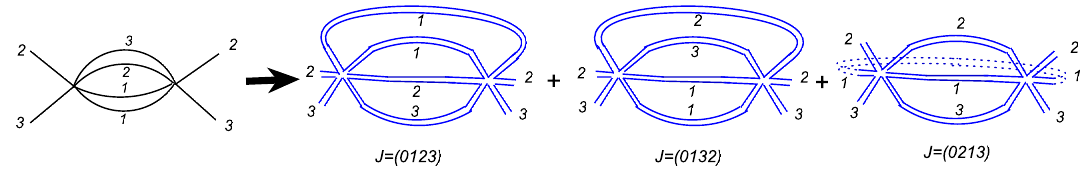
Figure 12 . An example illustrating the existence of a handle for one of the three J ’s in the case when two 6-valent vertices are connected by four lines. The 3 diagrams to the right of the arrow show the three blow-ups of this graph for the three di(cid:11)erent choices J = (0123), (0132) and (0213) respectively. In this example we see that only the third ordering develops a handle. Inserting a pair of 6-valent vertices of this type into a larger diagram therefore does not change the value of 1 V 6 (cid:0) ! since V 6 increases by two while ! increases by one. 2